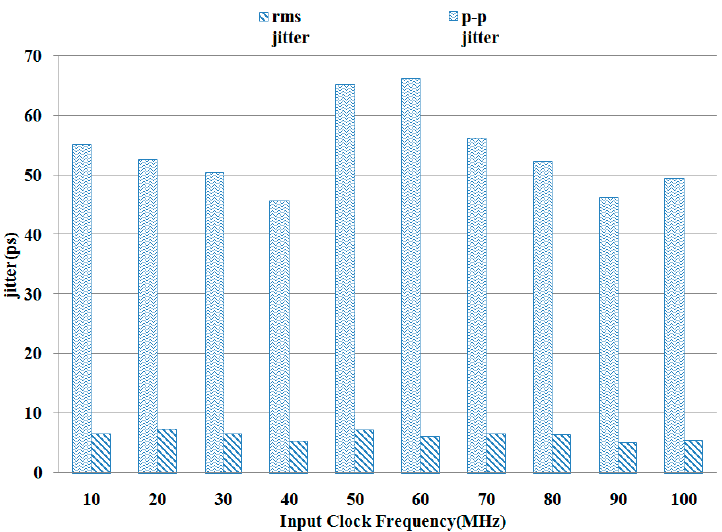
Electronics 2021 , 10 , x FOR PEER REVIEW Figure 14. Measured duty-cycle errors for different input duty cycles at 10 MHz–100 MHz. Figure 14. Measured duty-cycle errors for different input duty cycles at 10 MHz–100 MHz. Figure 14. Measured duty-cycle errors for different input duty cycles at 10 MHz–100 MHz.